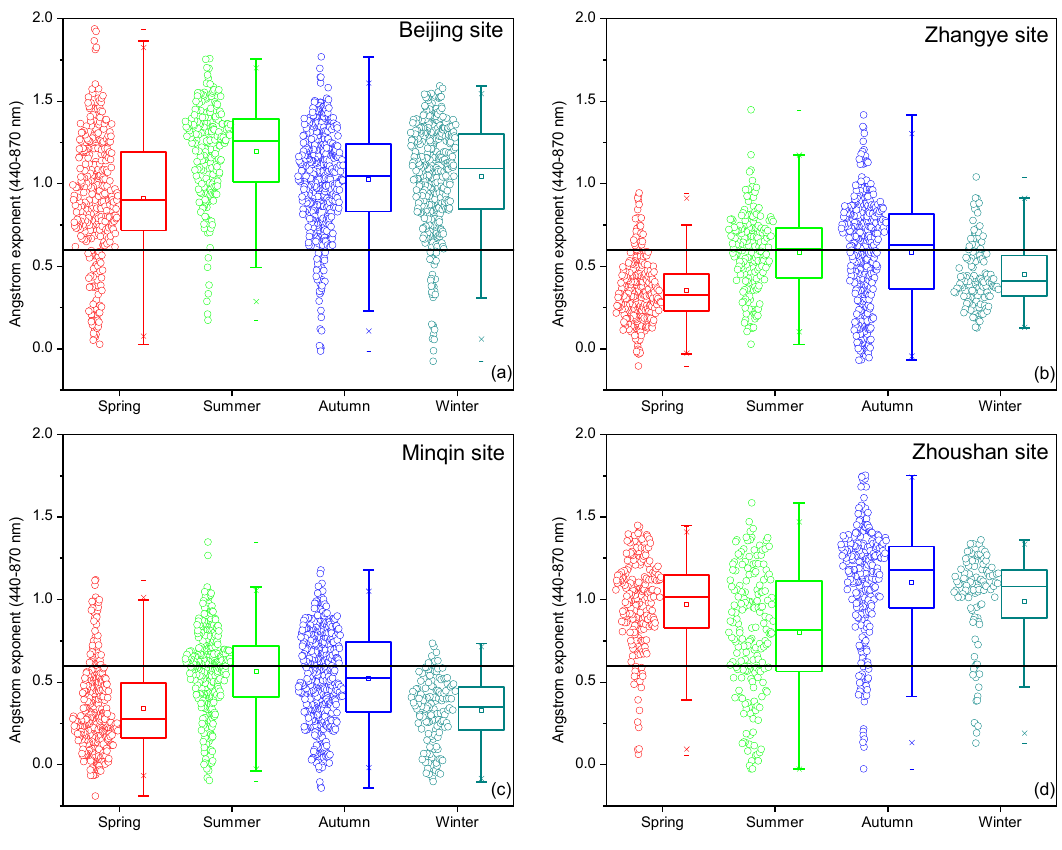
Figure 3. Ångström exponent indices statistics of the four sites. ( a ) Beijing site; ( b ) Zhangye site; ( c ) Minqin site; ( d ) Zhoushan site. The small squares and lines crossing in the box respectively denote mean and median values, the top and bottom short lines indicate maximum and minimum values, and the crosses denote the 1%–99% range. The box lines represent the lower quartile, median, and upper quartile values. The whiskers extend within 1.5 times of the interquartile range. The horizontal black lines indicate the dust aerosol (AE = 0.6, see Dubovik et al. [20]) in BJ, ZY, and MQ; for the ZS case, this threshold